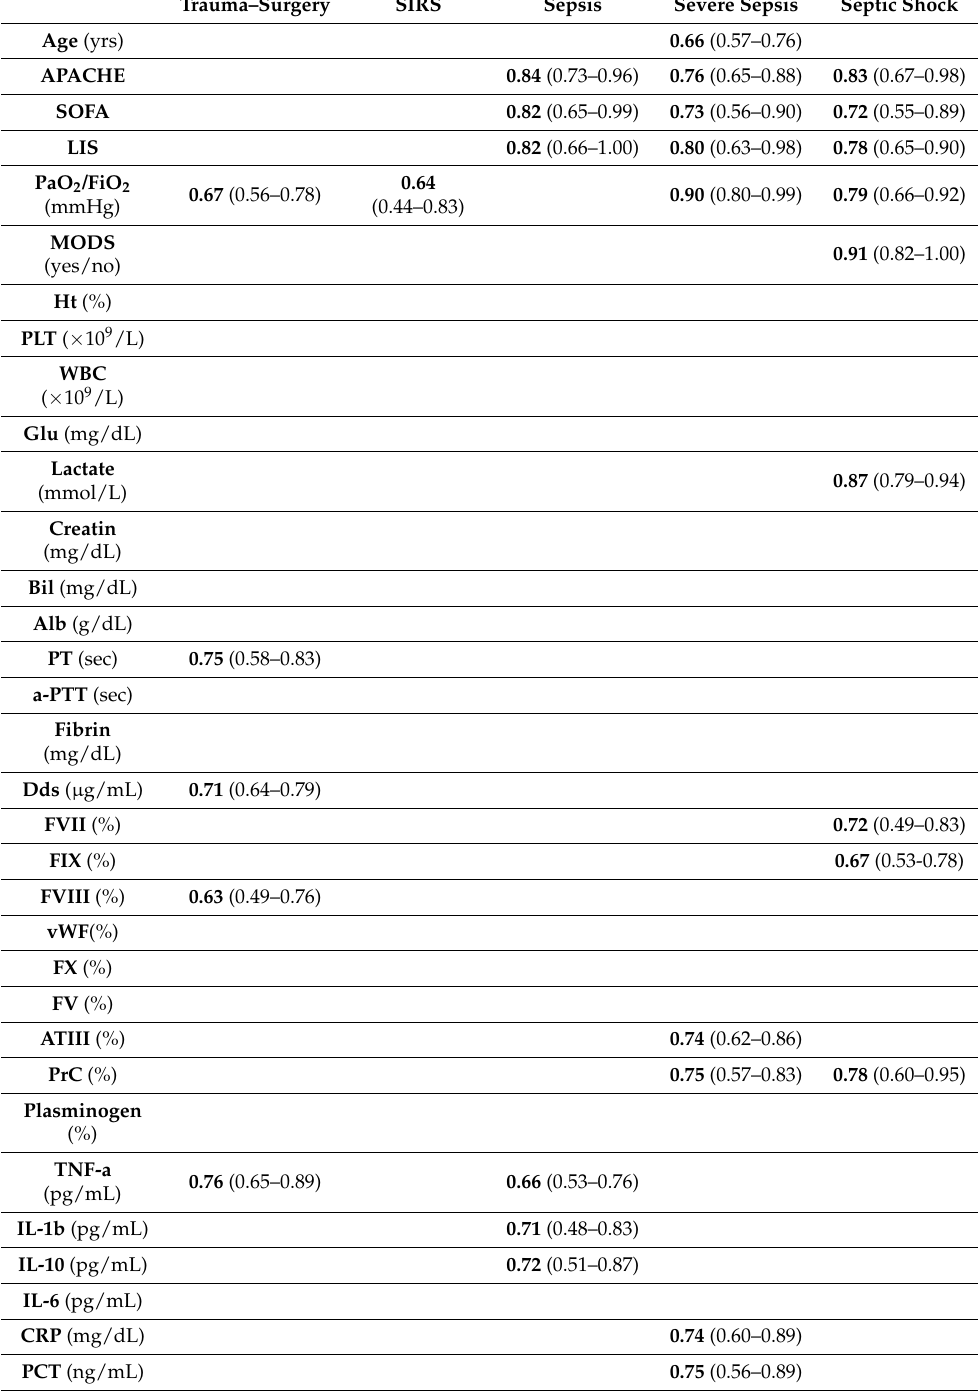
Table 8. Predictive value (Area Under the Receiver Operating Characteristic—AUROC (95% CI)), in the sense of patient temporary clinical deterioration or improvement, of the various factors and variables measured on ICU